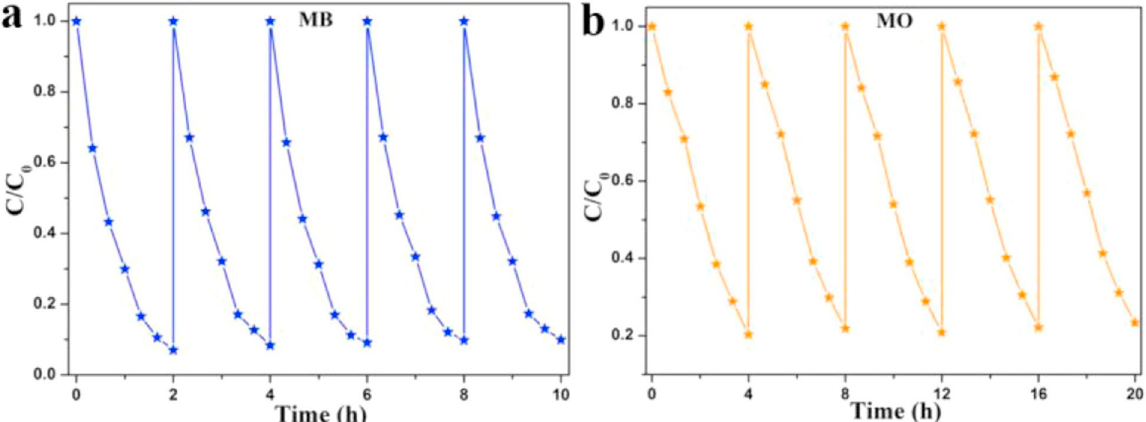
Figure 6. Four photodegradation reuse cycles of ( a ) MB and ( b ) MO with the optimized Ag@AgCl/ZnO on a glass plate. Adapted with permission from [98] . Copyright © 2018 Elsevier.